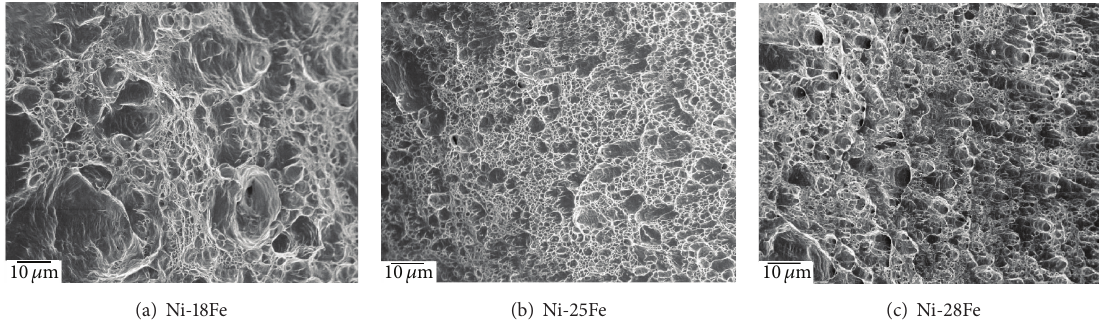
Figure 6: SEM fractographs of the ordered Ni 3 Fe with different stoichiometry when tested in vacuum.